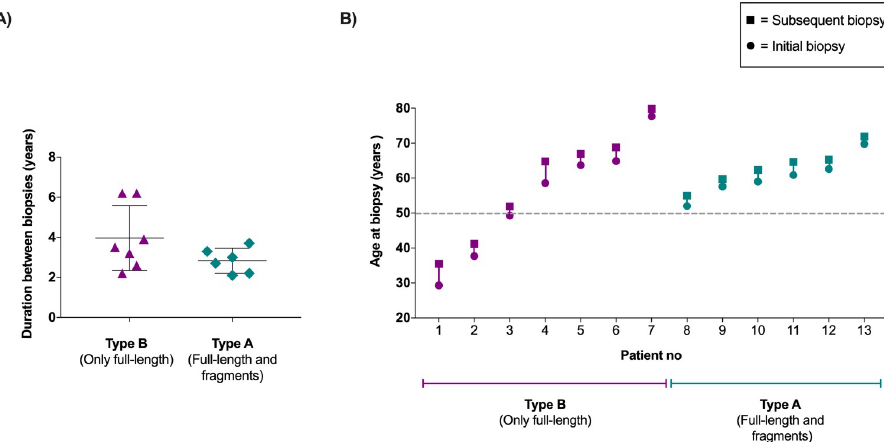
Fig 2. Duration and age, for patients whose fibril type already had been determined in two biopsies. (A) Duration between the initial and subsequent biopsy, grouped according to fibril type. Horizontal lines represents the mean value ± standard deviation. (B) Age at initial and subsequent biopsy. The grey dashed line represents the age at disease onset (50 years old) which most often is used to determine a patient as “early or late